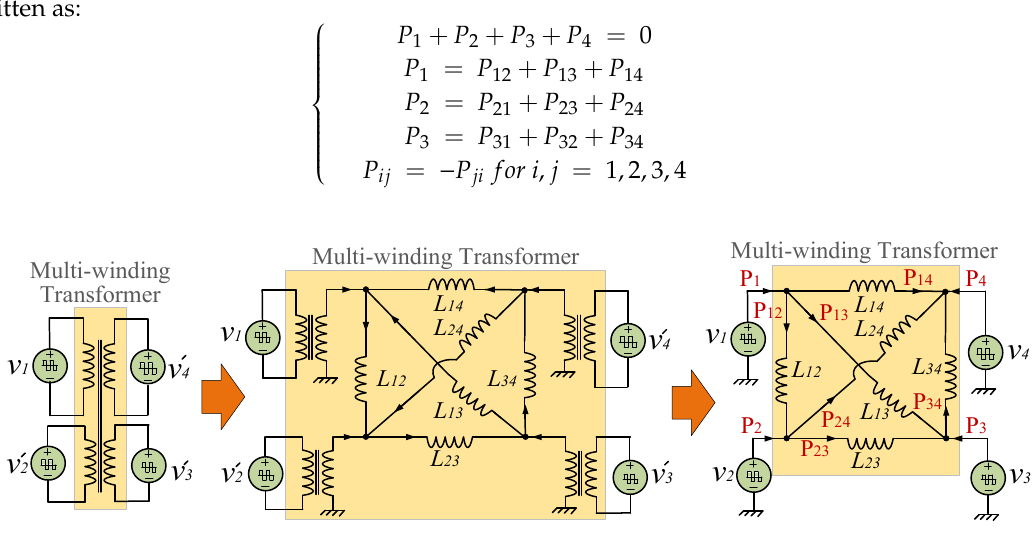
Figure 2. Simplified model of the four-port converter by simplifying the multi-winding transformer using cantilever model.